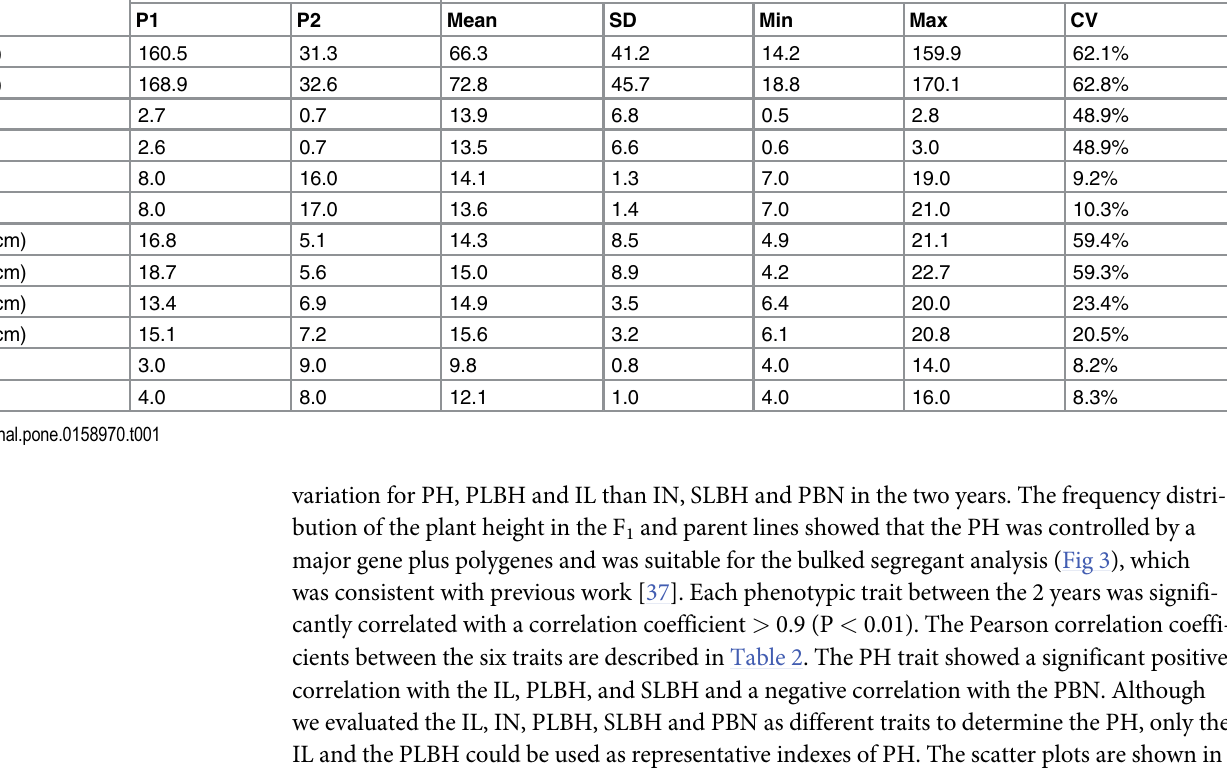
Table 1. Descriptive statistics of six traits for L . fauriei (P1) × L . indica ‘ Pocomoke ’ (P2) and the F 1 population over 2 years (2013 and 2014). Trait